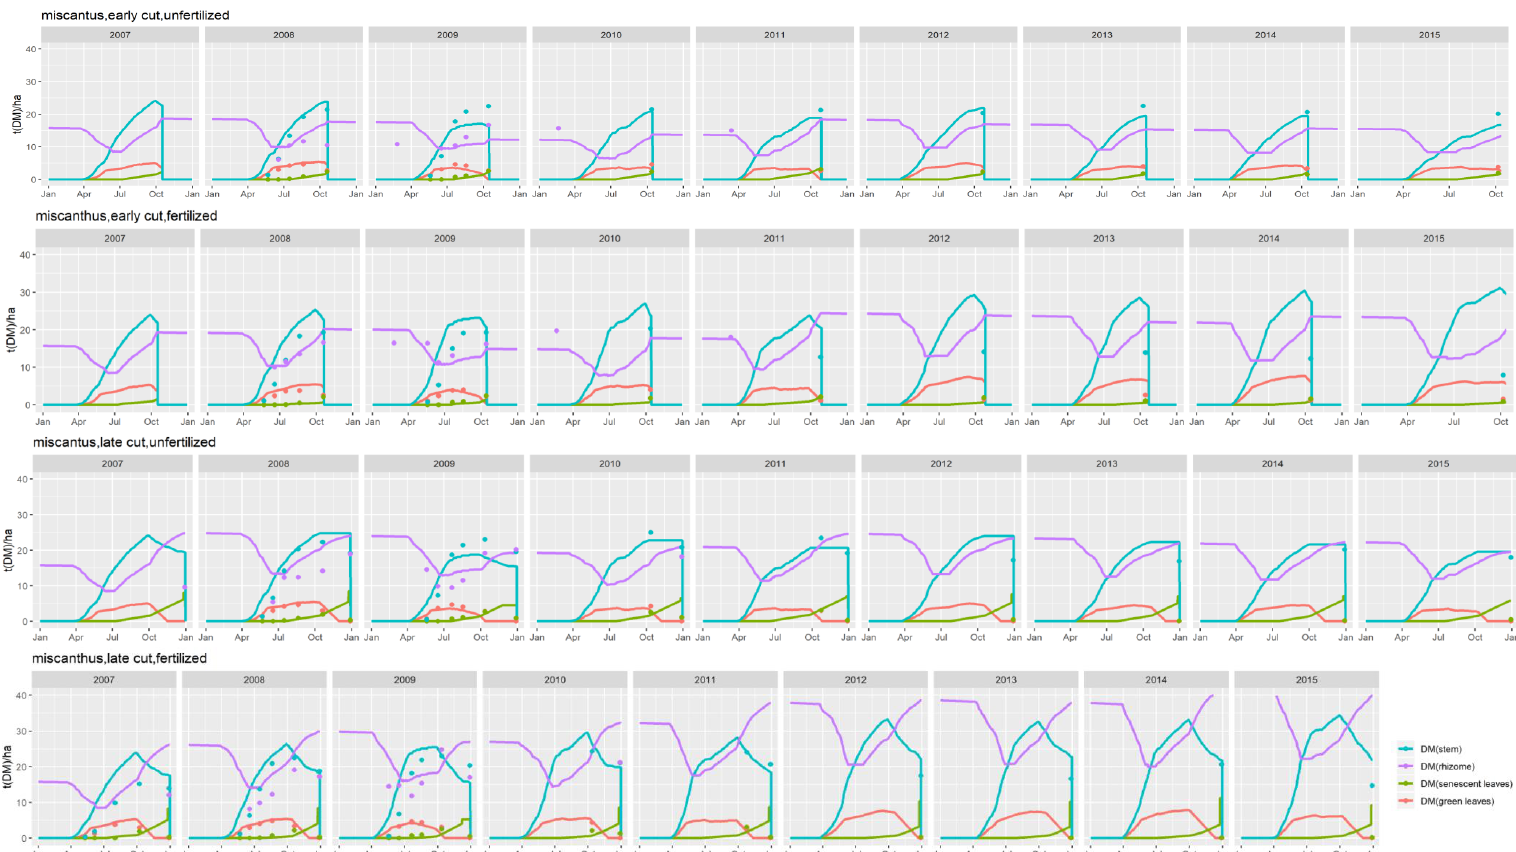
Figure 1. simulated (lines) and observed (symbols) dynamics of biomass in various plant compartments for the miscanthus trial in the Estrées-Mons calibration site, and for four treatments combining late and early harvests with two levels of N fertilizer inputs (0 and 120 kg N ha −1 ).